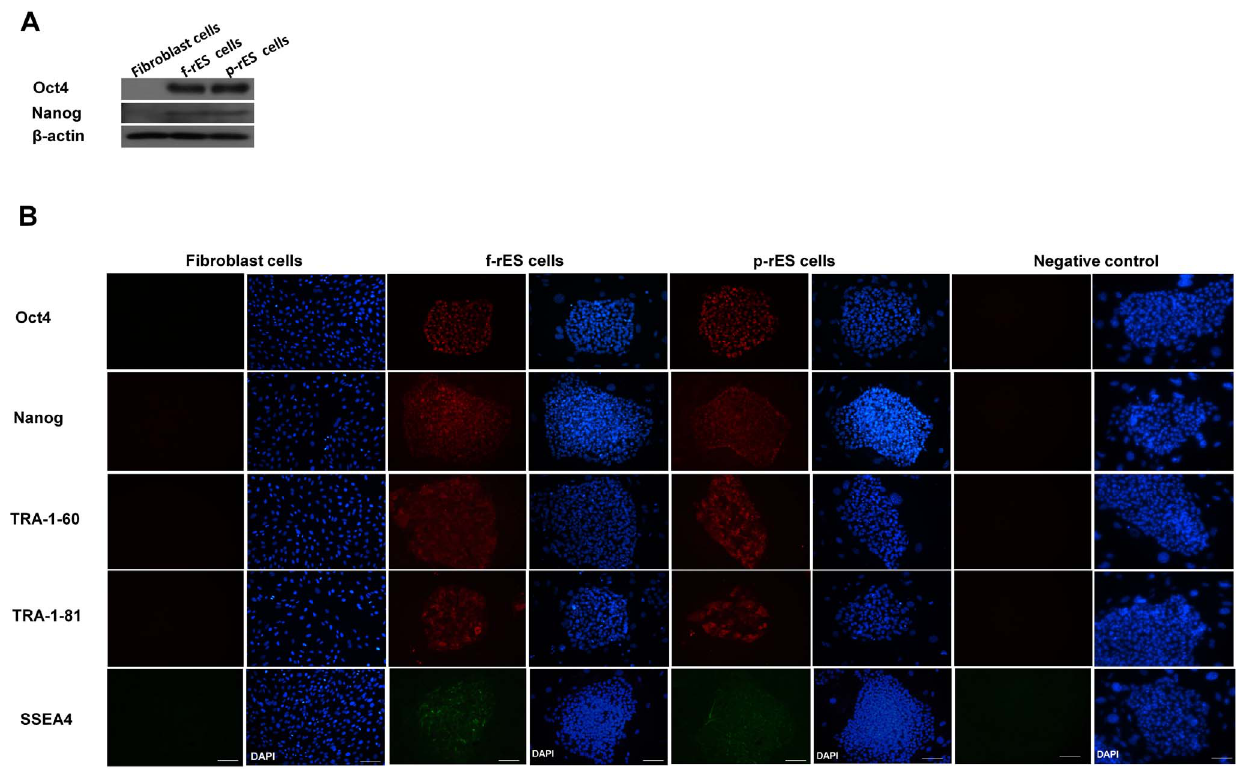
Figure 3. Analyses of expressions of pluripotency related gene in rabbit embryonic stem cells. (A) Western blot analyses of Oct4 and Nanog expressions in rabbit fibroblast, f-rES, and p-rES cells. Note that both f-rES and p-rES cell lines expressed all the pluripotency markers. Beta- actin is served as a loading control. (B) Immunocytochemical analyses of marker expressions of the three cell types (fibroblast, f-rES, and p-rES cells). The rES cell line expressed the markers recognized by antibodies against Oct4, Nanog, TRA-1-60, TRA-1-81, and SSEA-4. The nucleus is labeled by DAPI, and negative control is only stained with secondary antibody without primary antibody. Scale bar=100 m m.